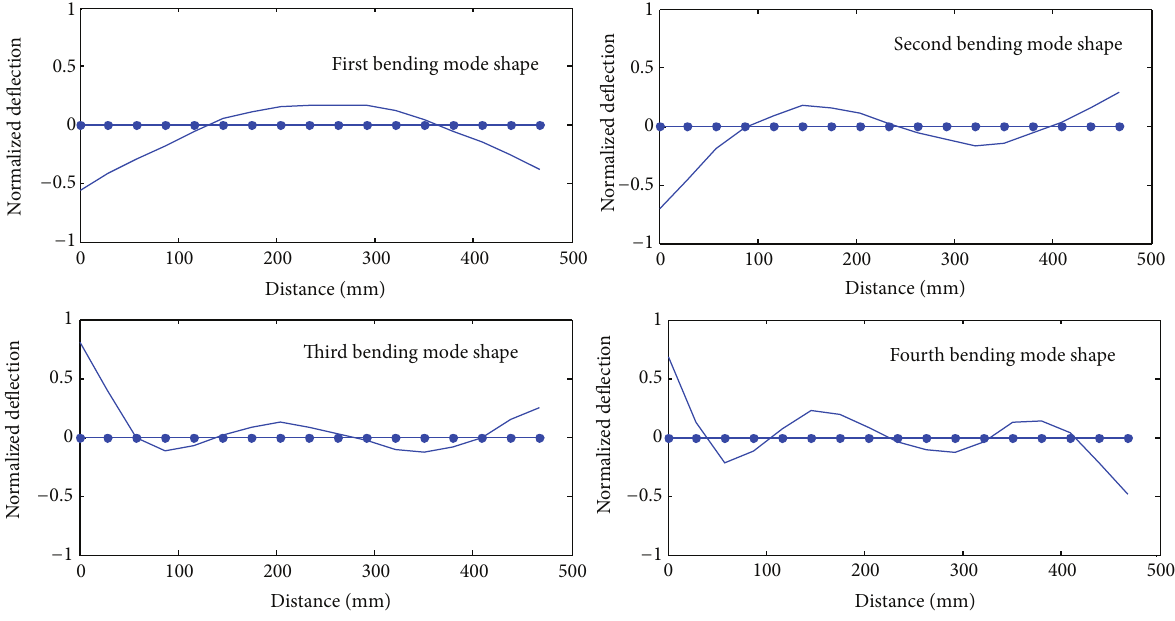
Figure 5: Experimental free-free rotor mode shapes.